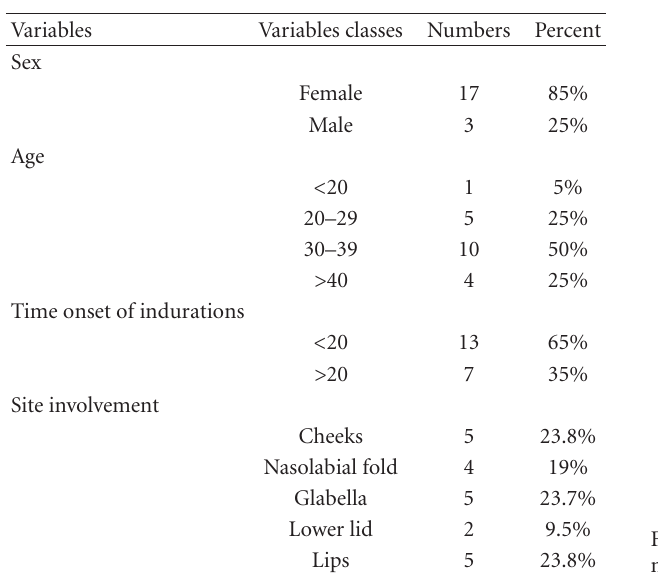
Table 1: Characteristics of patients.